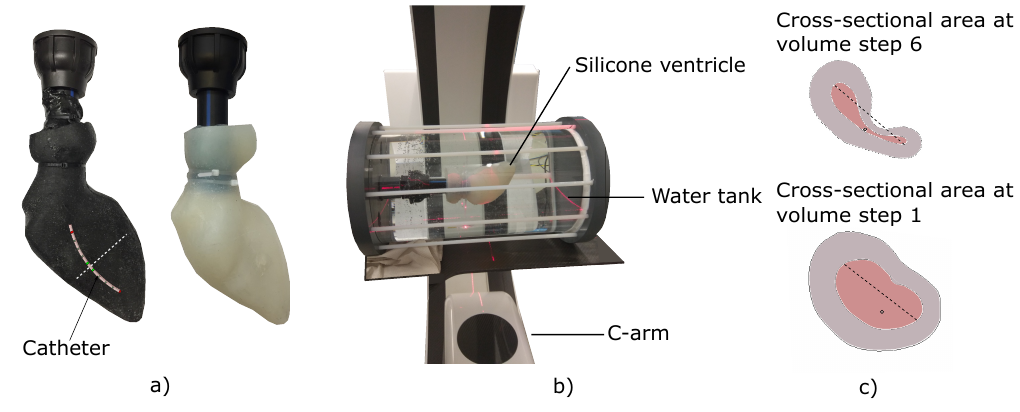
Figure 5: a) Left ventricular in-vitro phantoms made from silicone (left: carbon, right: pure), b) C-arm with manual test bench to measure phantom dimension, c) Cross-sectional areas obtained from CT measurements at the center electrode pair, adapted from [32].